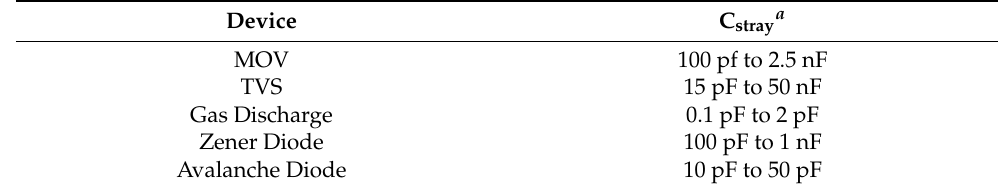
Table 2. Typical stray capacitance values for protective devices.